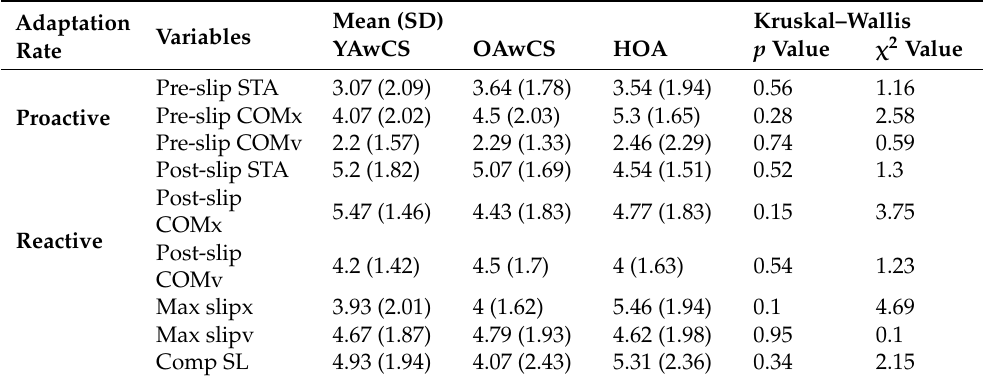
Figure 2. Trial-to-trial changes in percentage of backward balance losses for young adults with chronic stroke (YAwCS), older adults with chronic stroke (OAwCS) and healthy older adults (HOA) during a block of eight consecutive slips delivered to the non-paretic (for YAwCS and OAwCS)/dominant side (for HOA) (S1–S8). The slip outcome was a dichotomous variable with “1” assigned for backward loss of balance and “0” for no loss of balance. The total number of participants who experienced balance loss in each group during each slip trial is represented as a percentage in the figure. The figure shows that 100% of participants in each of the 3 groups (YAwCS, OAwCS and HOA) experienced loss of balance during the novel slip (S1). There were subsequent reductions in percentages of loss of balance with repeated perturbations such that 0% of participants in each of the 3 groups experienced loss of balance by the 8th slip (S8). Table 2. Means and standard deviations of adaptation rate for all the kinematic variables. Kruskal– Wallis test was conducted to examine the group effect on the adaptation